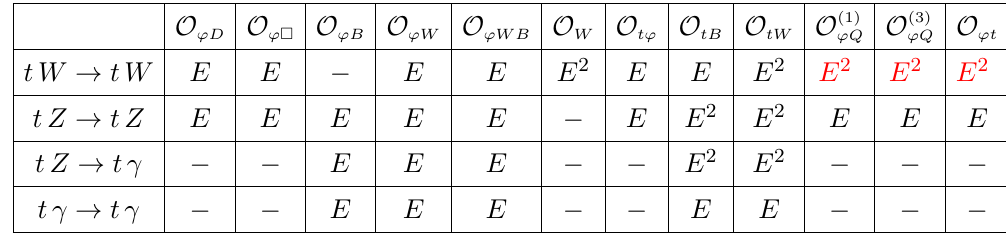
Table 7. Same as table 5 for two top scattering amplitudes without the Higgs. See tables 13{16 for the full helicity amplitude results.